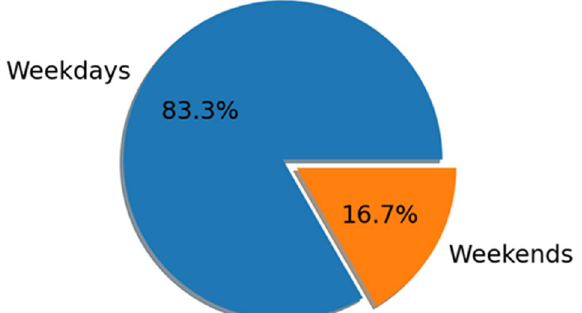
Fig. 18 Distribution of weekdays (Monday-Friday) and weekend days (Saturday-Sunday) in cluster 0 for the 2019 dataset (48 samples in